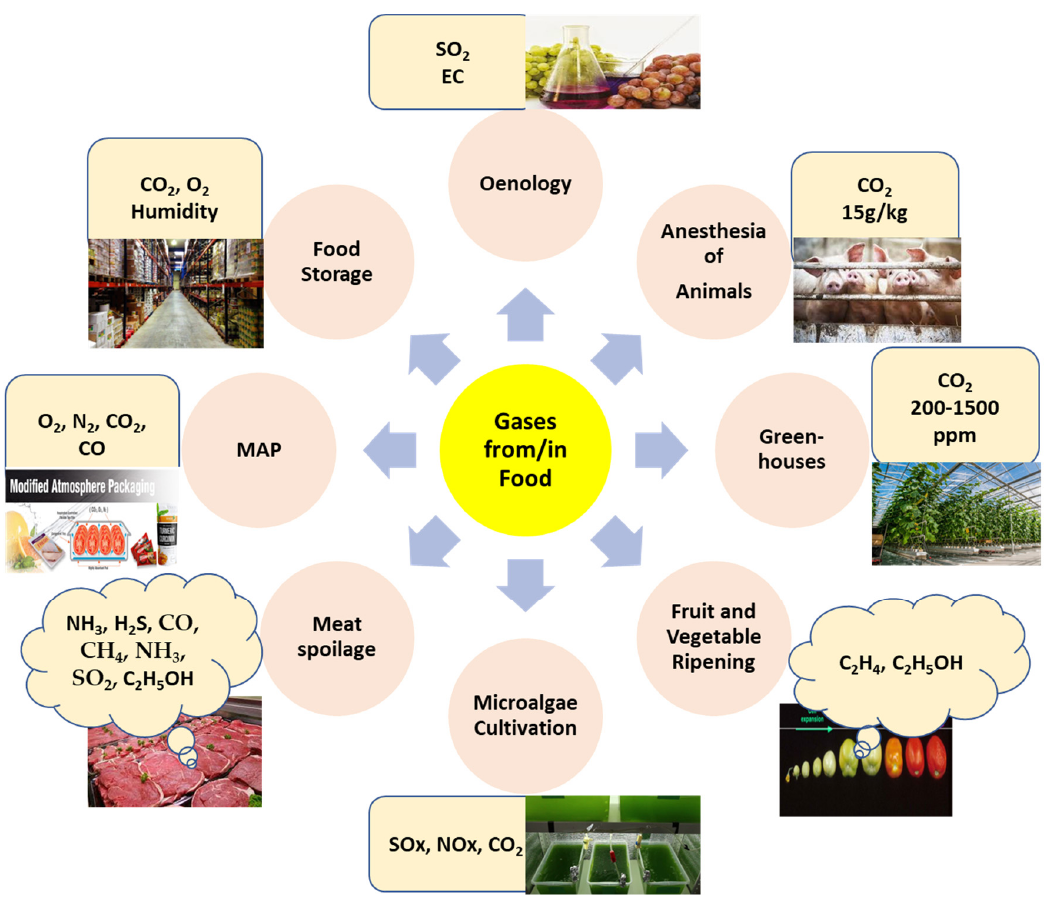
Figure 2. Scheme of the gases used in or produced from food operations.